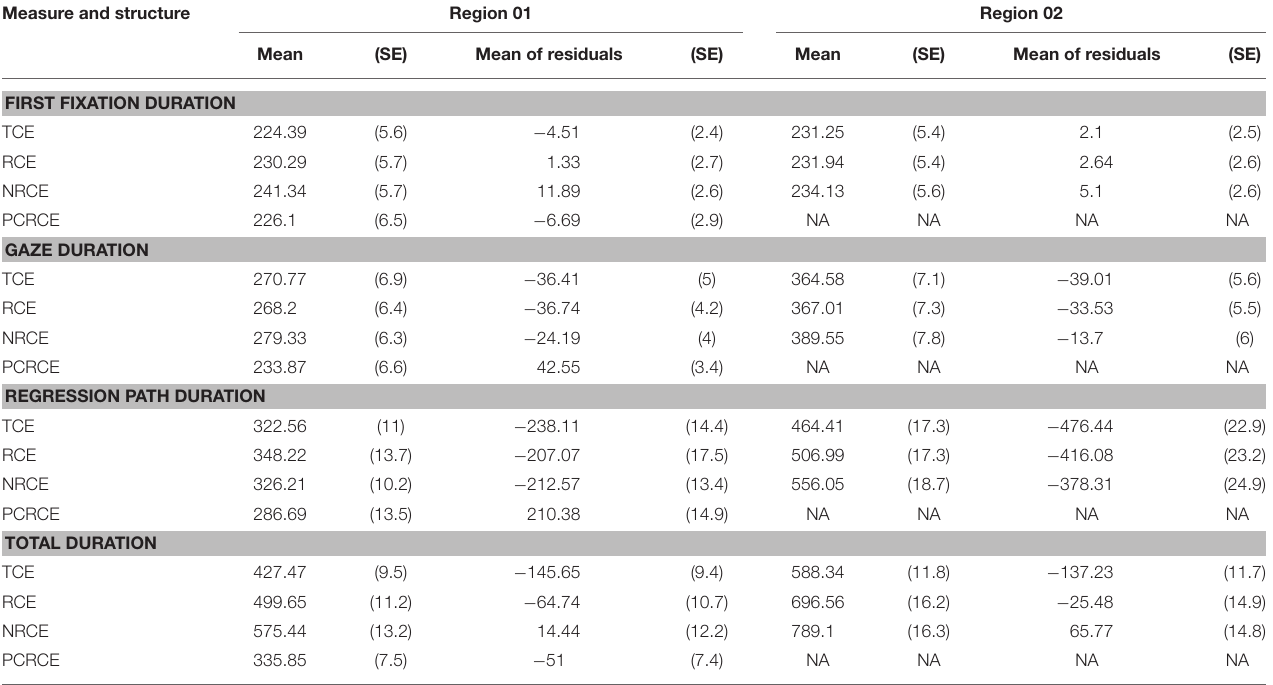
TABLE 3 | Experiment 1 mean and mean residual fixation durations for Structure. Measure and structure Region 01 Region 02 Mean (SE) Mean of residuals (SE) Mean (SE) Mean of residuals